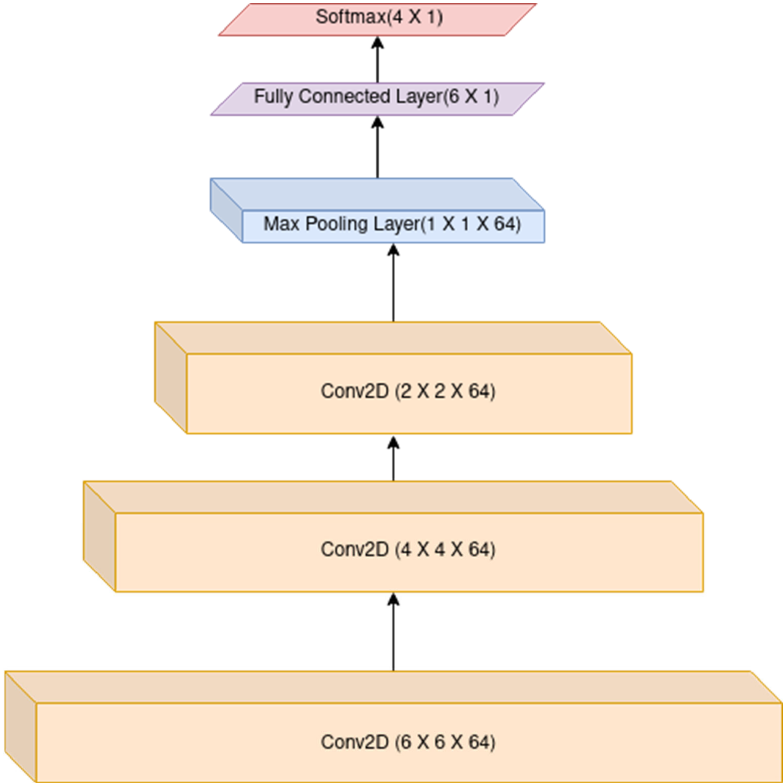
Figure 5. Illustration of the proposed custom ‐ built CNN architecture with 4 output classes for the WESAD dataset and 3 in the case of the SWELL dataset. Table 1. Overview of the customized CNN architecture used in the present work.